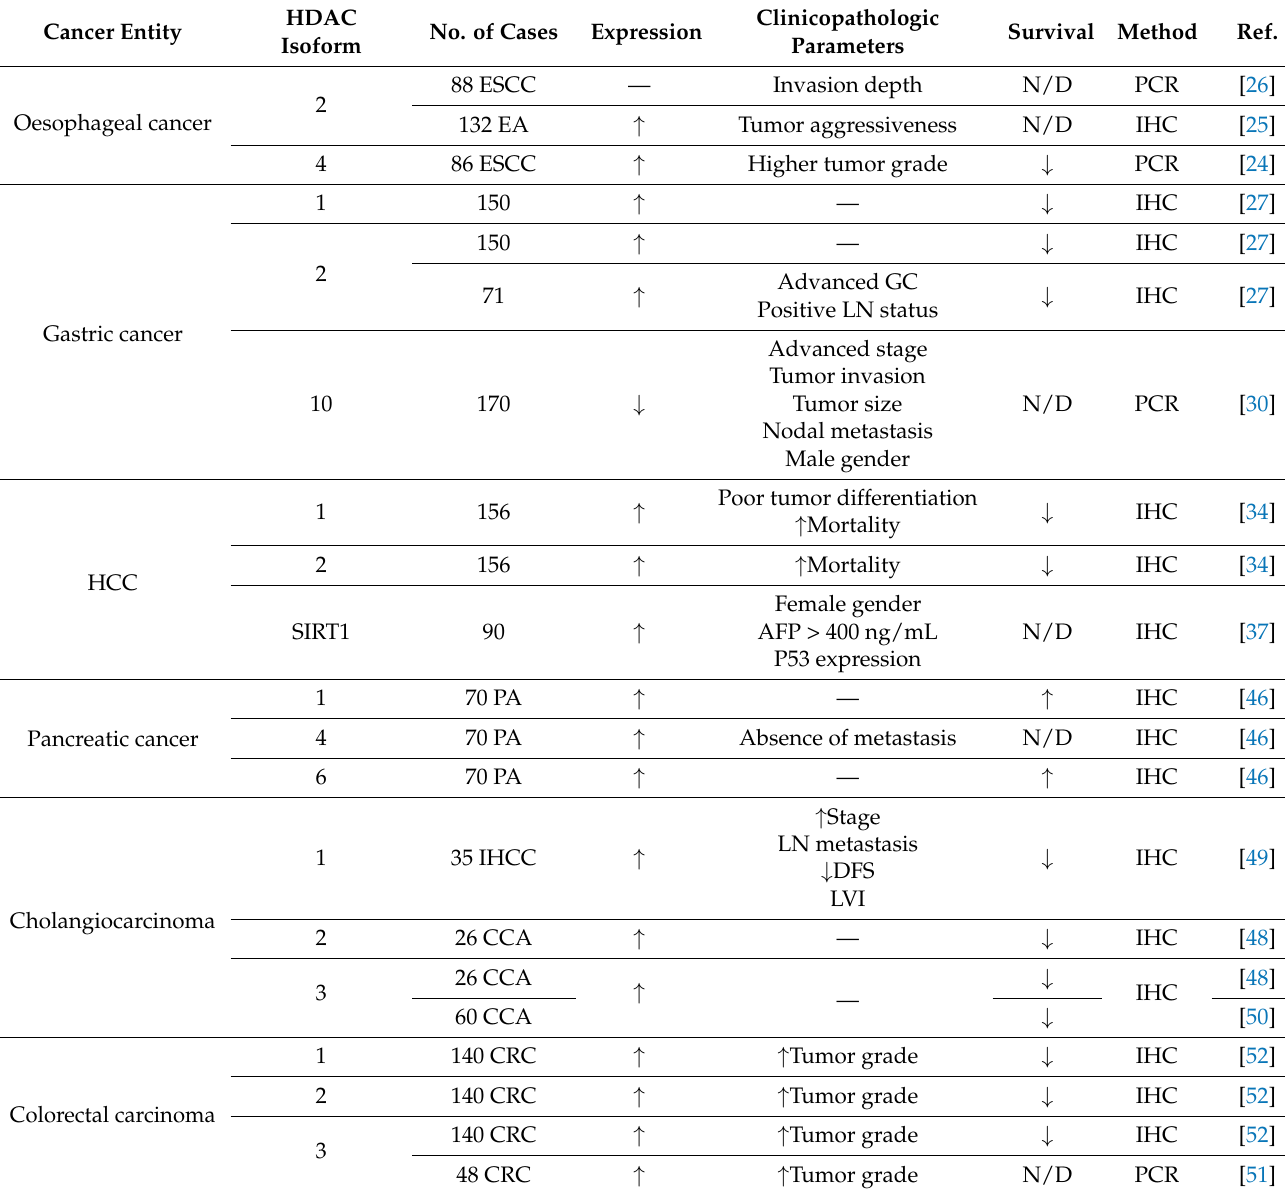
Table 3. Association of different HDAC isoforms expression in gastrointestinal tract and pancreatobiliary tumors and their correlation with clinicopathological parameters and patients’